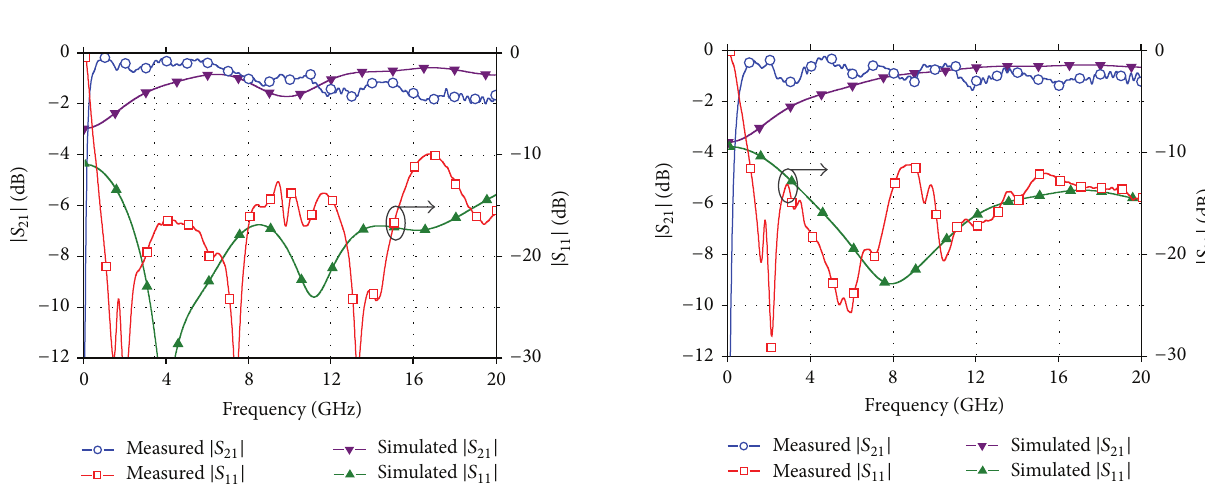
Figure 7: Simulated and measured performance of the Type A tran- sition.